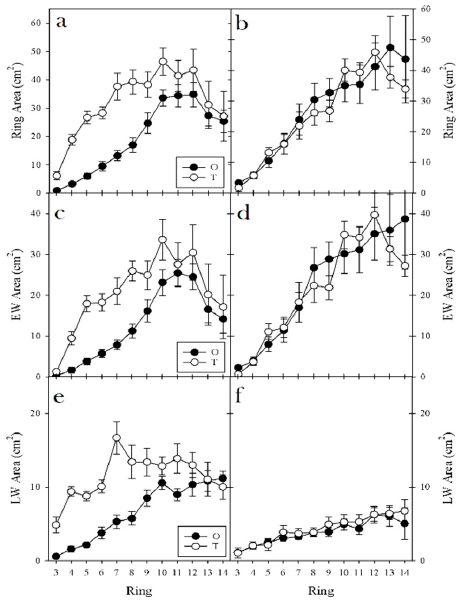
Figure 6. Ring area ( a , b ); earlywood area ( c , d ); and latewood area ( e , f ) for: Douglas-fir ( a , c , e ); and western redcedar ( b , d , f ) trees growing under contrasting vegetation management treatments on a site located in the Cascade Foothills of western Oregon. O: no post-planting vegetation control (open symbol); T: sustained vegetation control during first five years post planting (filled symbol). Error bars represent standard error.